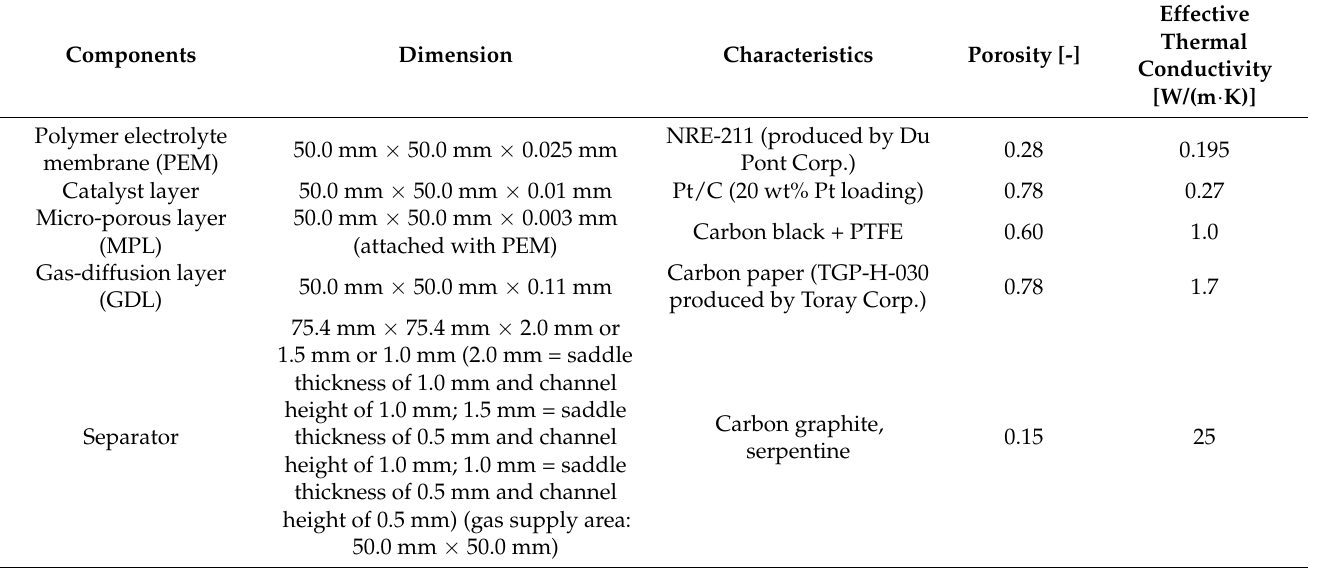
Table 1. Specification list of polymer electrolyte fuel cell components, according to the manufacturer’s catalog and previous studies